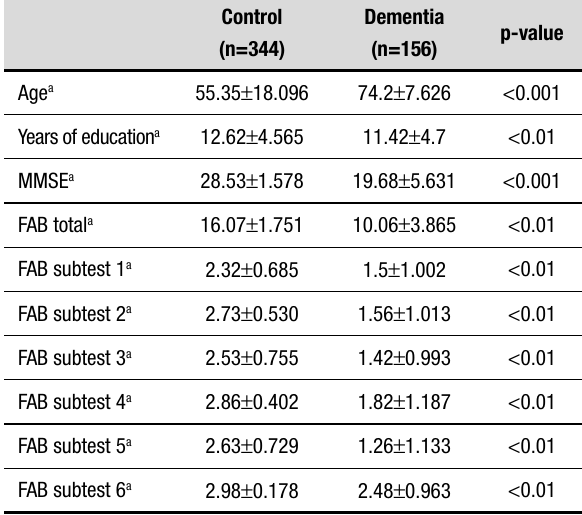
Table 1. Demographic and neuropsychological characteristics of healthy controls and